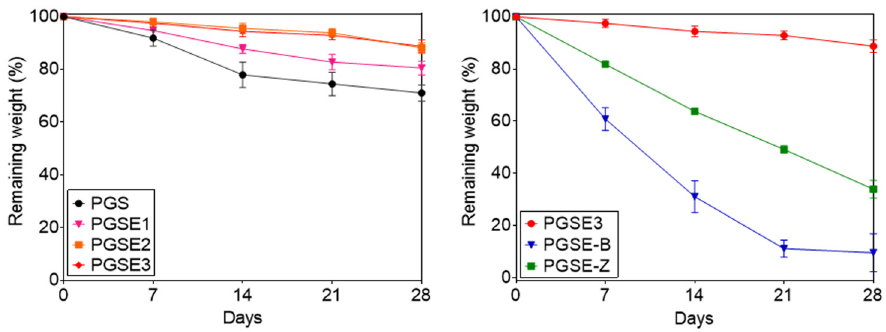
Figure 7. In vitro enzymatic degradation of PGS, PGSE1, PGSE2, PGSE3, PGSE-B, and PGSE-Z.